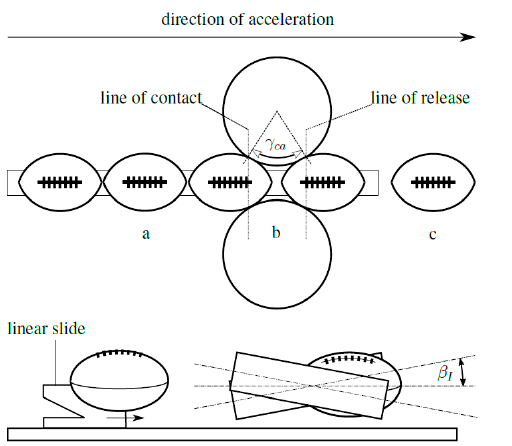
Figure 1. Three phases of the acceleration process, a: delivery phase, b: contact phase, c: free flight phase. The figure shows one ball at equidistant time steps of the process. Therefore, it can be seen that the ball is faster in phase b and c than in phase